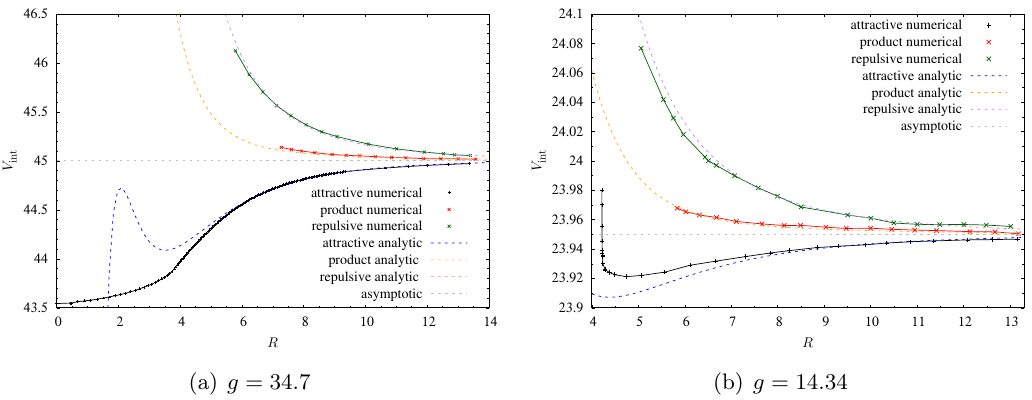
Figure 10 . Interaction potential extracted from numerical simulations for (a) g = 34 : 7 and (b) g = 14 : 34. The product channel is made by translating a copy of one Skyrmion by R in some direction. The attractive channel takes the translated Skyrmion and rotates the it by (cid:25) around and axis perpendicular to the axis separating them. The repulsive channel takes instead the trans- lated Skyrmion and rotates it by (cid:25) around the axis that separates them. The mass parameter is m = 0 :